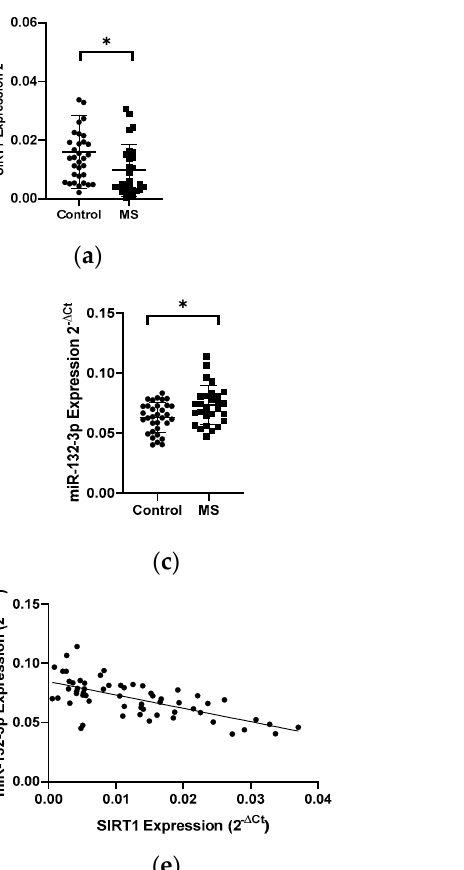
Figure 4. Expression levels and correlations of SIRT1, miR-34a, and miR-132-3p in PBMCs from multiple sclerosis patients and healthy controls. Expression levels (2 - Δ Ct ) are shown for: ( a ) SIRT1, ( b ) miR-34a, and ( c ) miR-132-3p. ( d , e ) Spearman correlation (R) plots for the expression levels of SIRT1 with miR-34a and miR-132-3p (combined for all cohorts; N = 61). The PBMCs were from multiple sclerosis patients ( N = 27). Expression levels were determined by real-time PCR (see Methods). Statistical analysis of differences between the groups of data was carried out using the Mann–Whitney U-test. Values of p ≤ 0.05 were regarded as statistically significant ( p * ≤ 0.05, p ** ≤ 0.01).